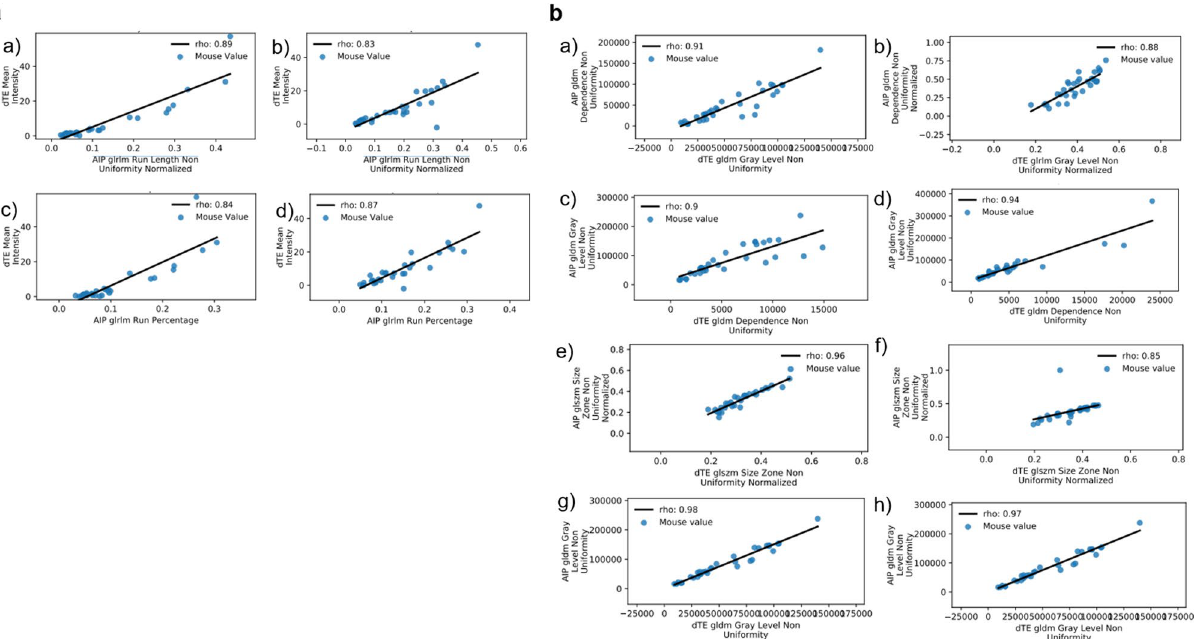
Figure 2. GLRLM Gray-level run length matrix, GLDM Gray-level dependence matrix, GLSZM Gray-level size zone matrix. Bivariate scatter plots of raw feature data comparing selected features and those extracted from spatial mapping of the dTE. ( a ) Scatter plots of raw image feature data showing strong Spearman correlation between the dTE parameter and AIP image features from treated (a, c) and control (b, d) animals. ( b ) Scatter plots of raw image feature data showing strong Spearman correlation between statistically selected features from the spatially mapped dTE parameter and AIP image features in treated (a, c, e, g) and control (b, d, f, h) animals.